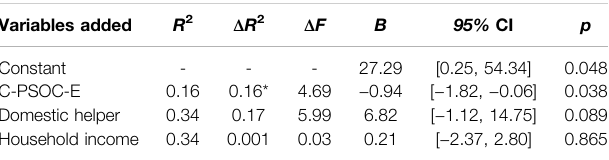
TABLE 4 | Hierarchical linear regression analyses predicting the variances in children ’ s CSBS scores. Variables